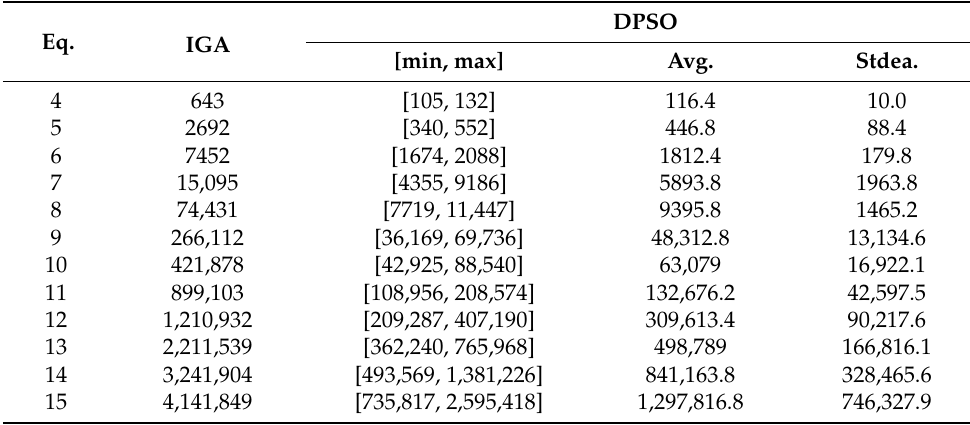
Table 9. Multi-algorithm iteration number comparison